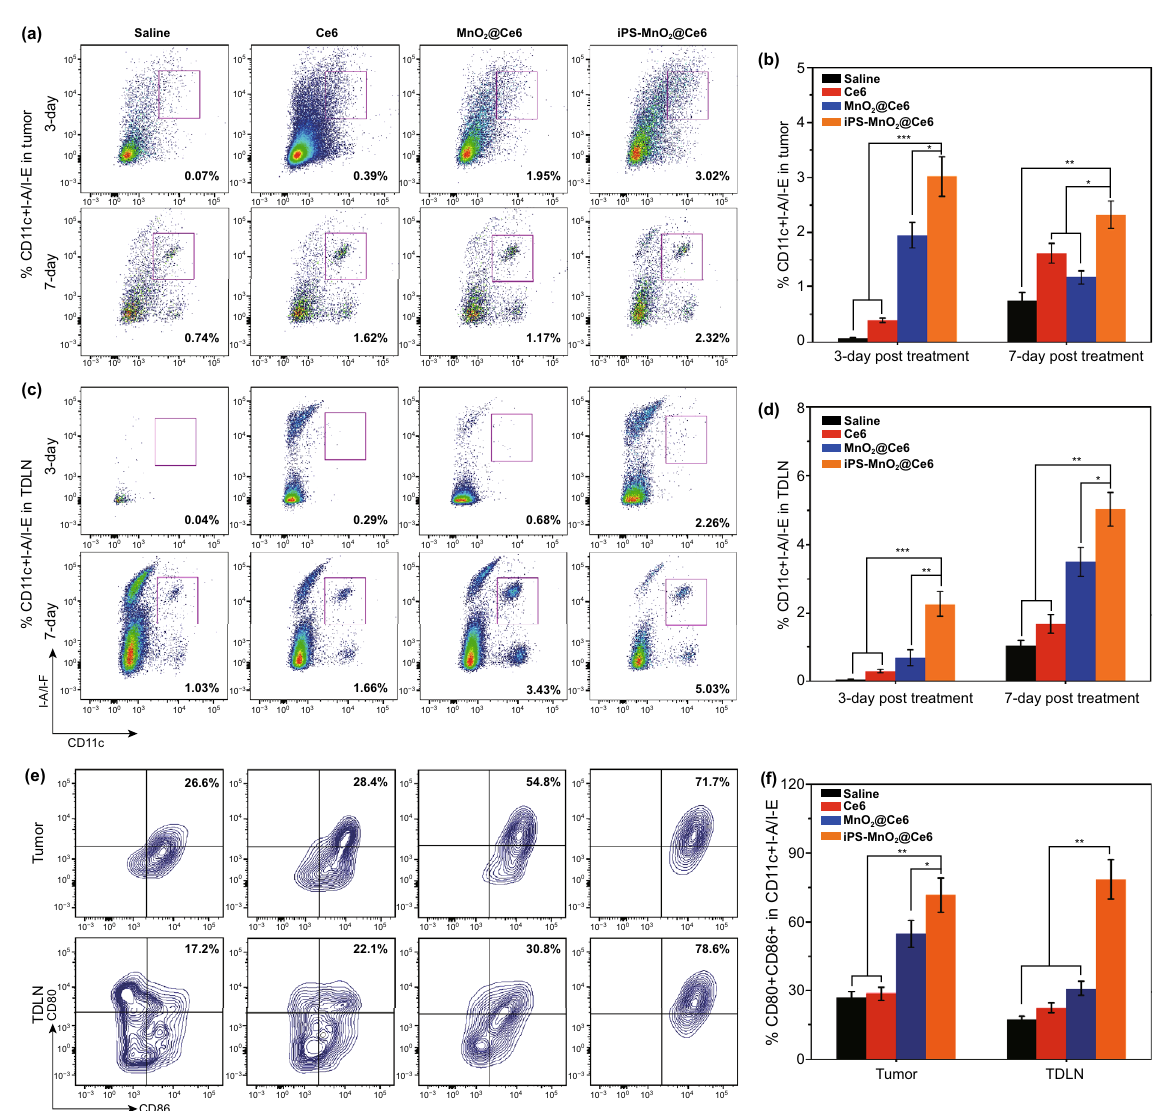
Fig. 5 The infiltration and maturation of DCs treated by iPS-MnO 2 @Ce6-mediated photodynamic therapy in tumor tissues and lymph nodes. a – d DCs infiltrating in tumor tissues ( a , b ) and tumor-draining lymph nodes (TDLN) ( c , d ) were analyzed by flow cytometry after stained with Liver-Dead, CD45+, CD11c+, I-A/IE. e, f Mature DCs in tumor tissues and DTLN 7 days after the treatment were stained with CD80 and CD86 for flow cytometry assay. Data were expressed as mean ± SD, ( n = 5, * P < 0.05, ** P < 0.001, *** P <